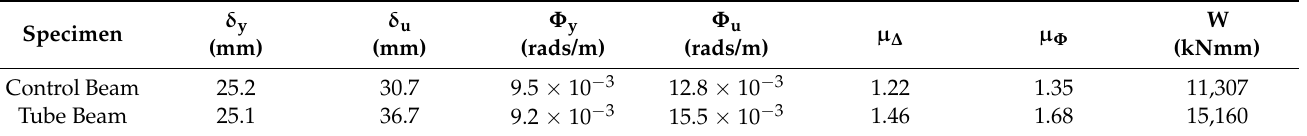
Table 4. Yield and ultimate deflections and curvatures determined from experimental curves, ductility indices, and energy capacities for control and tube beams.